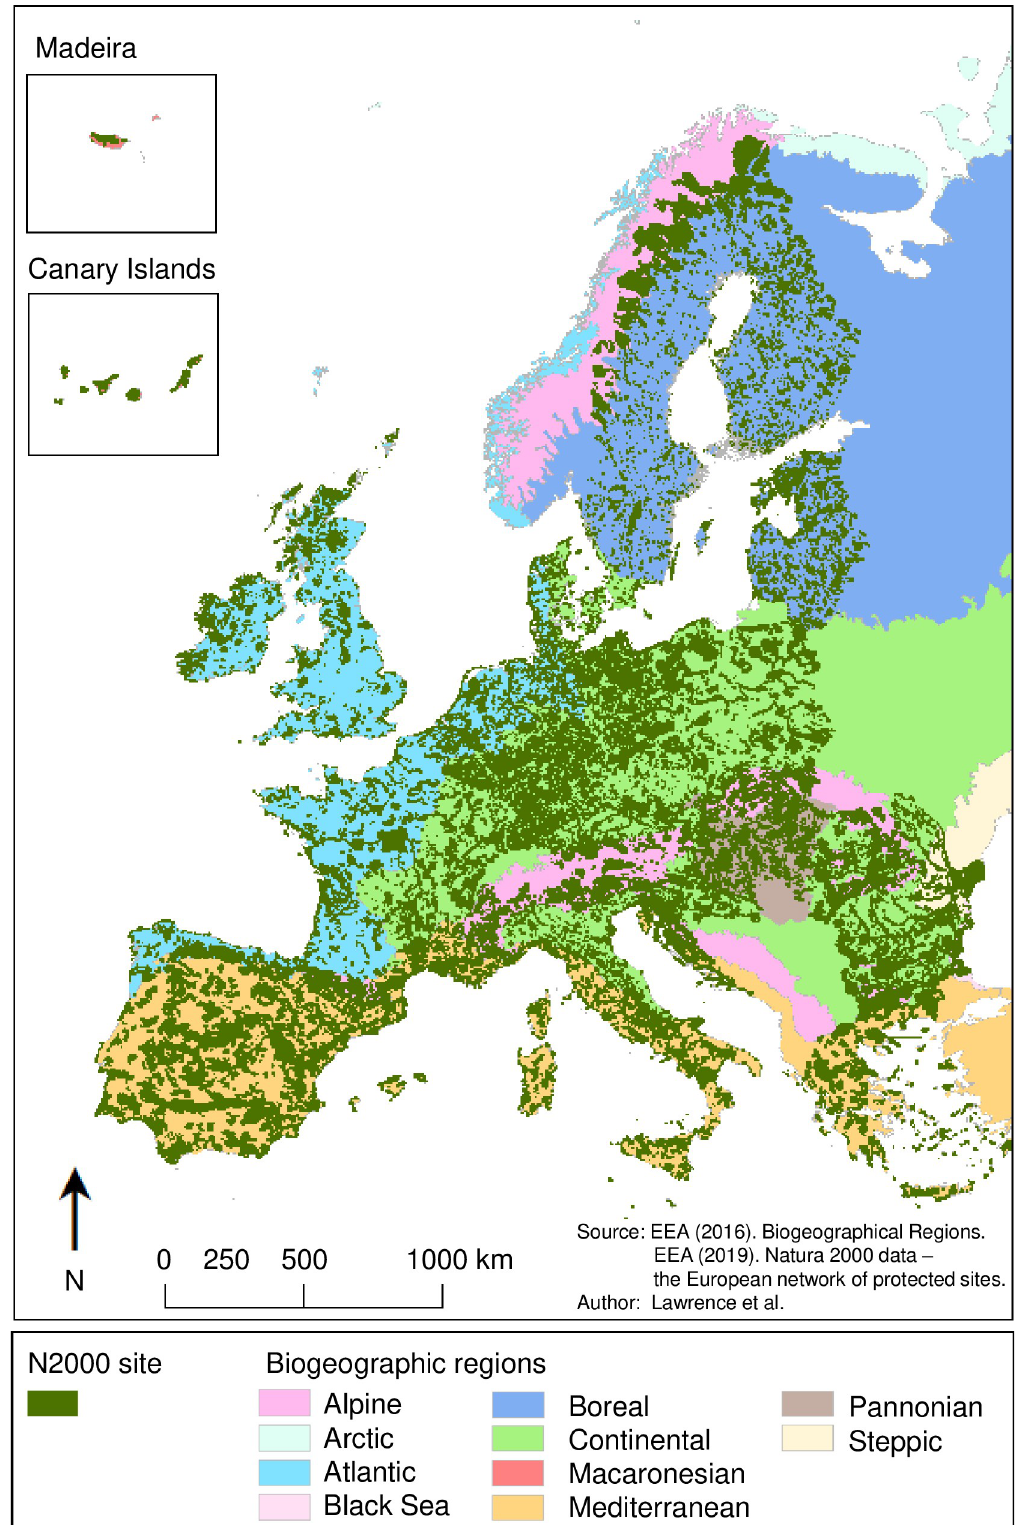
Fig 1. The European N2k network across nine biogeographical regions. Dark green polygons represent terrestrial N2k sites analysed in this study [47]. Map generated in ArcGIS 10.6.1 (http://www.esri.com/software/arcgis/arcgis-for-desktop).